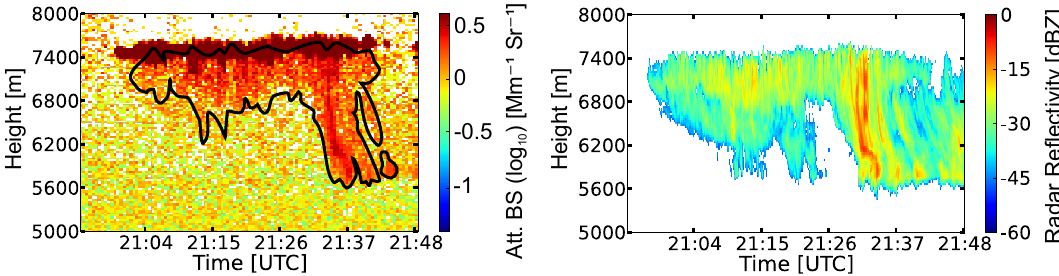
Figure 4. Lidar and radar observations on 2 August 2012 (case 2). Left: 532 nm attenuated backscatter coefficient; right: radar